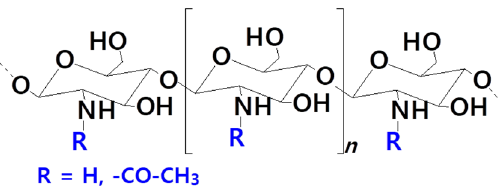
Figure 4. Chemical structure of chitosan.